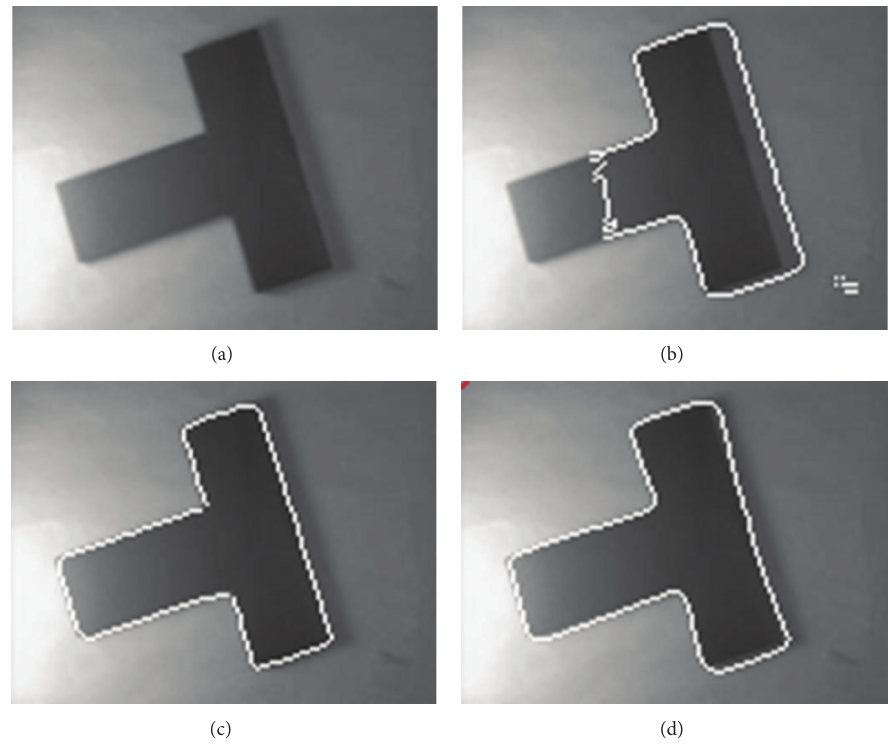
Figure 1: Image for segmentation. (a) Original image. (b) Result using CV model. (c) Result using mean shift method. (d) Segmentation result using proposed